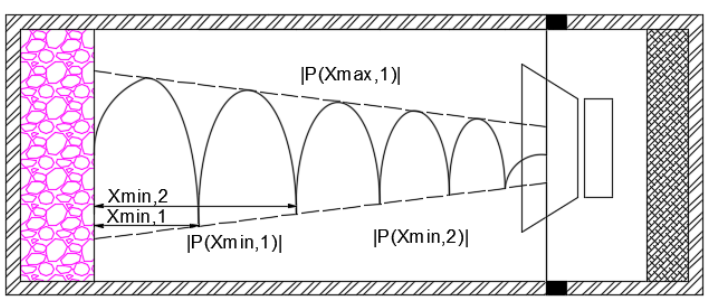
Figure 2. Schematic of a curvature.